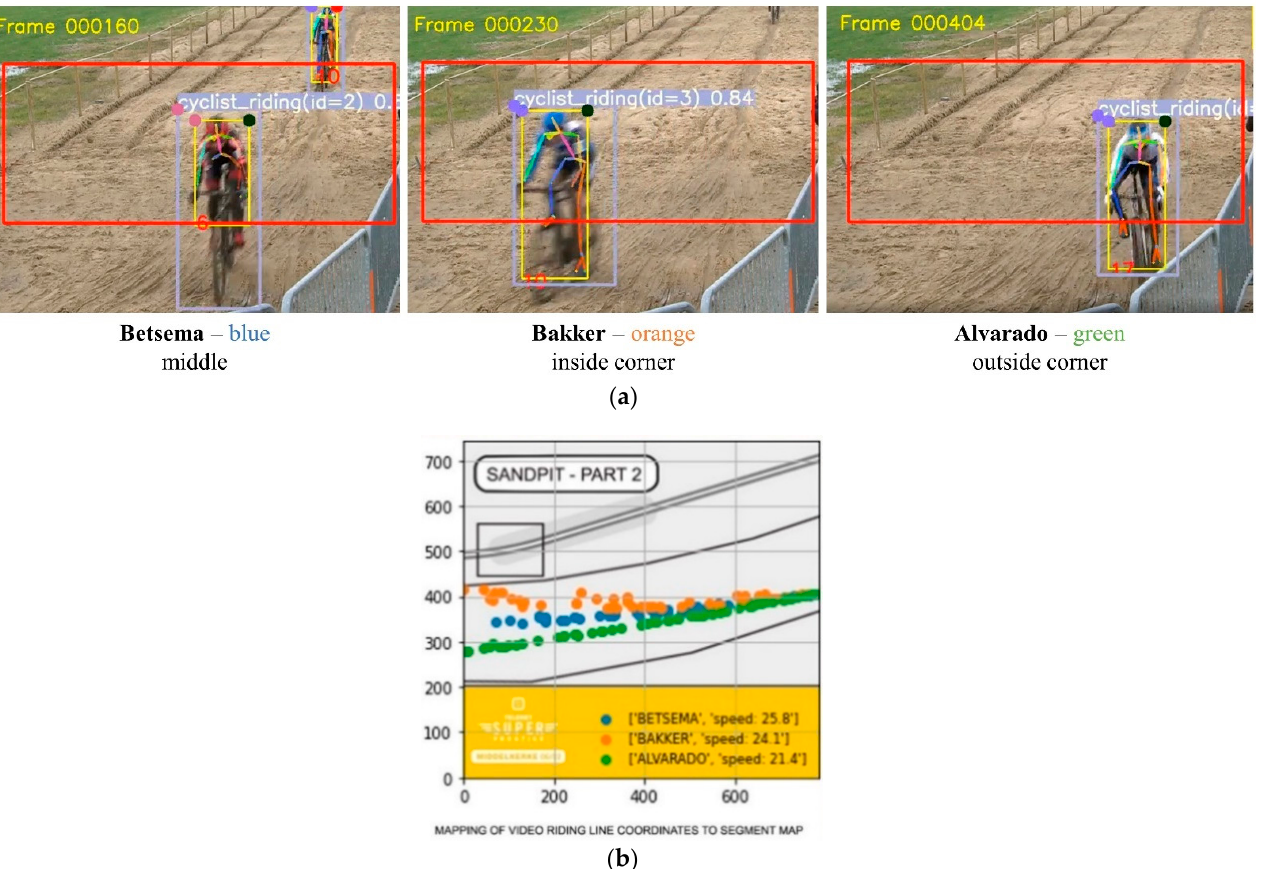
Figure 10. ( a ) Three female riders riding different lines through the sandpit in a professional cyclocross race. The red numbers are the tracking identifiers of the pose tracker. ( b ) Schematic overview of the produced fence paths of the various riders that went through the fence (riders go through the fence from the right to the left). Results can be linked with the riders’ pictures in the fences on ( a ).